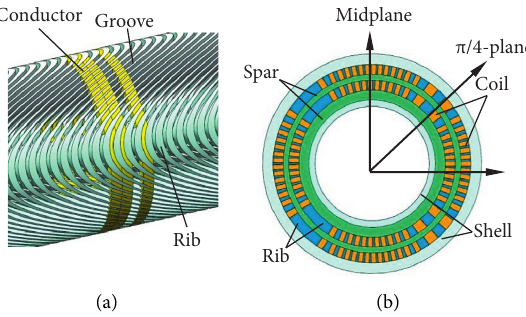
Figure 2: Mechanical drawing of quadrupole former with partial conductors and the cross section of the magnet.